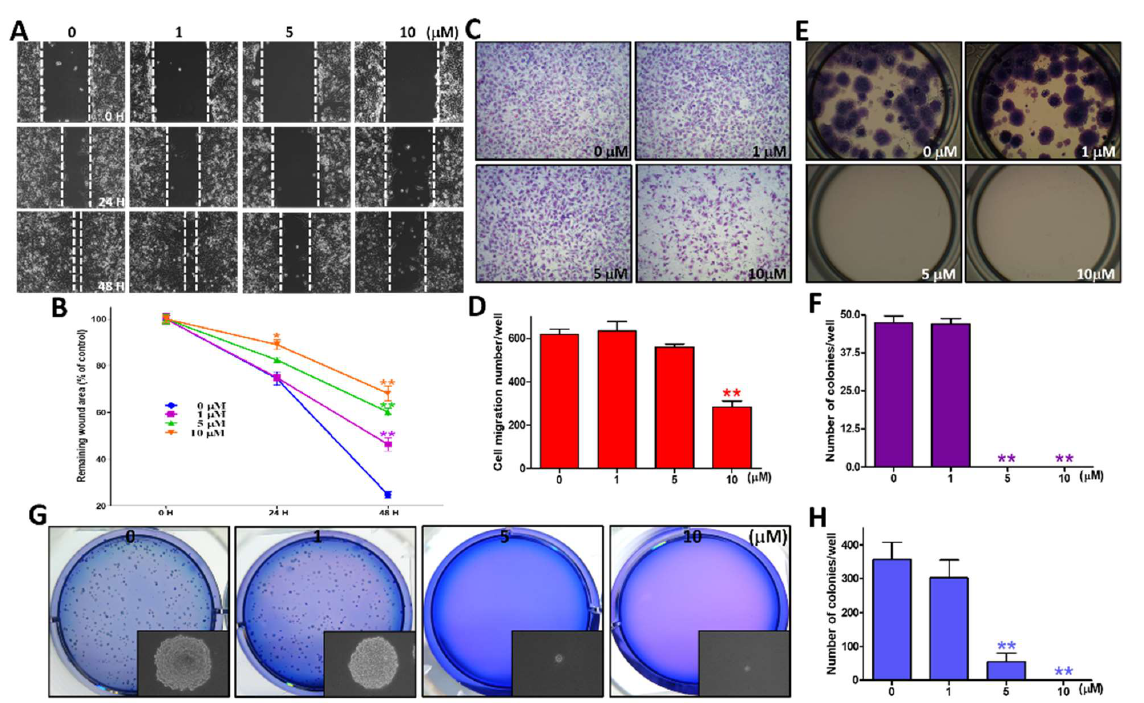
Figure 4. The effects of various concentrations of sinularin treatment on wound healing, cell migration, and colony formation of SK-HEP-1 cells. ( A ) The cells were scratched and treated with 0, 1, 5, and 10 µ M of sinularin for 0, 24, and 48 h, and then photographed by phase-contrast microscopy at 100 × magnification. ( B ) Statistics of the wound areas (blank indicates no cells) in the scratch-test assay, quantified using ImageJ software after being normalized with the time point 0 h at different concentrations of sinularin. ( C ) The profile of migration cells treated with 0, 1, 5, and 10 µ M of sinularin for 4 h before being evaluated for chemotactic potency, captured by phase-contrast microscopy at 100 × magnifications. ( D ) Quantification of the migration cell count using PhotoCapt software. ( E ) Colony formation morphology of attached cells. The cells were added to different concentrations of sinularin and incubated for 10 days, followed by fixation with 100% methanol and staining with 10% Giemsa stain. ( F ) Quantification of the number of colonies. ( G ) The soft agar colony formation assay was used to analyze the non-adherent growth ability of SK-HEP-1 cells after 14 days of co-culture with different concentrations of sinularin. A phase-contrast inverted microscope was used to photograph the pattern of cell colonies before staining, as shown in the under right corner of the frame. After staining with Giemsa stain, a digital camera was used to photograph the SK-HEP-1 colonies. ( H ) Quantification of the number of soft agar colonies. Each bar represents the mean ± SE of three independent experiments. The results were analyzed using Student’s t -test to determine the significance, in which * p < 0.05 and ** p < 0.01, relative to the control (sinularin-untreated